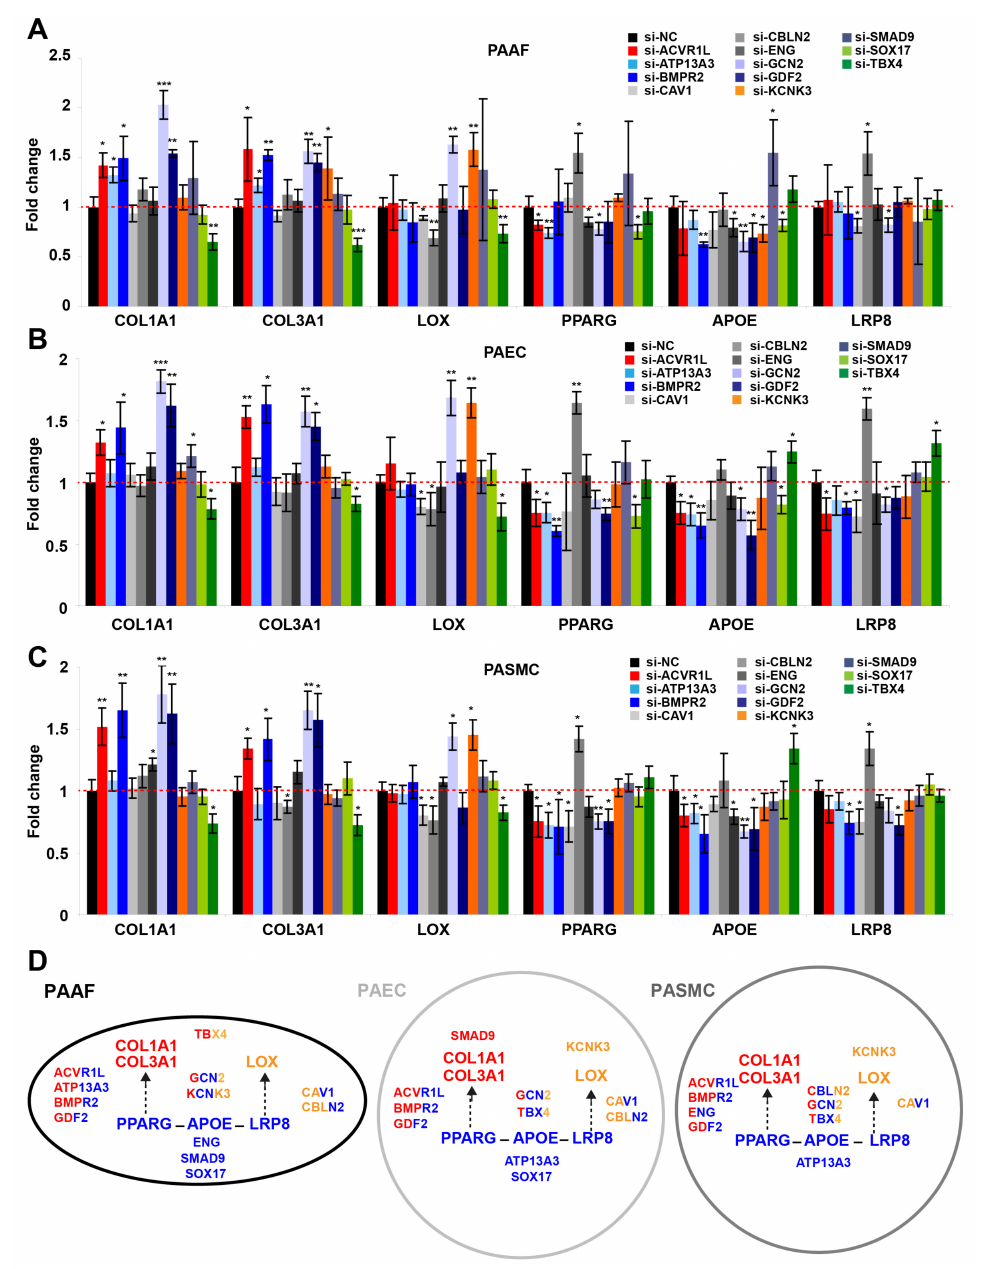
Figure 4. Upstream factors linked to hereditary PAH modulate the PPAR γ -APOE-LRP8 axis, which in turn controls pulmonary vascular matrix stiffening. ( A – C ) Following transfection with the indicated siRNAs, transcripts related to the PPAR γ -APOE-LRP8-matrix remodeling axis were analyzed by RT-qPCR in PAAFs ( A ), PAECs ( B ), and PASMCs ( C ). Mean expression of a given miRNA in the control group (si-NC) was assigned a fold change of 1, to which corresponding miRNA levels in experimental groups were compared. Data are expressed as mean ± SD (* p < 0.05, ** p < 0.01, *** p < 0.001) of three independent experiments. One-way ANOVA and post-hoc Tukey tests were used for group comparisons. ( D ) Schematic of the main results. In each cell type, the central downstream PPAR γ -APOE-LRP8-LOX-collagen axis is drawn. Factors genetically linked to PAH are strategically placed next to the portion of the axis which they regulate; font is also color-coded based on these connections. Blue: genes related to the PPAR γ -APOE-LRP8 axis; Red: genes related to fibrillar collagen; Orange: genes related to